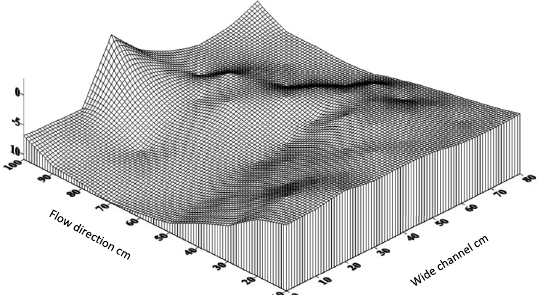
Fig. 7 3D model of bed channel downstream sharp-crested weir at apron solid 150-cm length, 25-cm weir height, and discharge 25